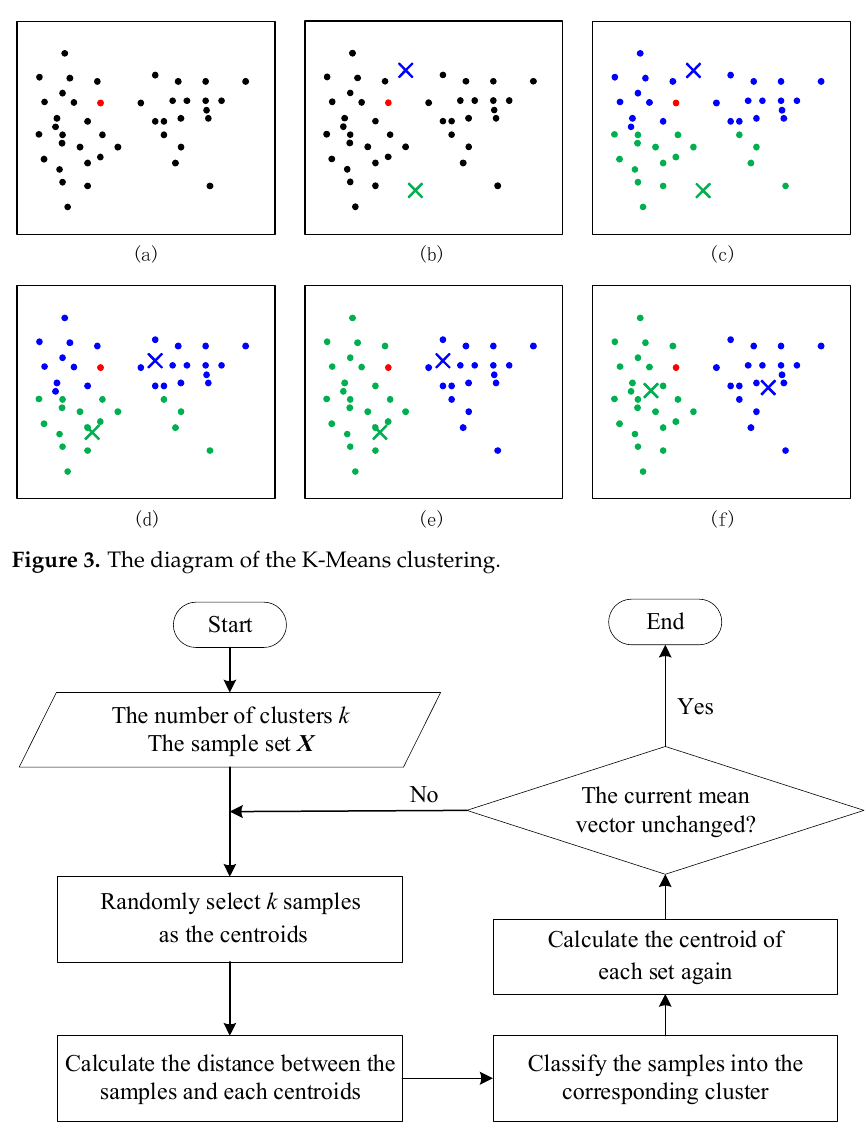
Figure 4. The flowchart of the coordinate clustering.